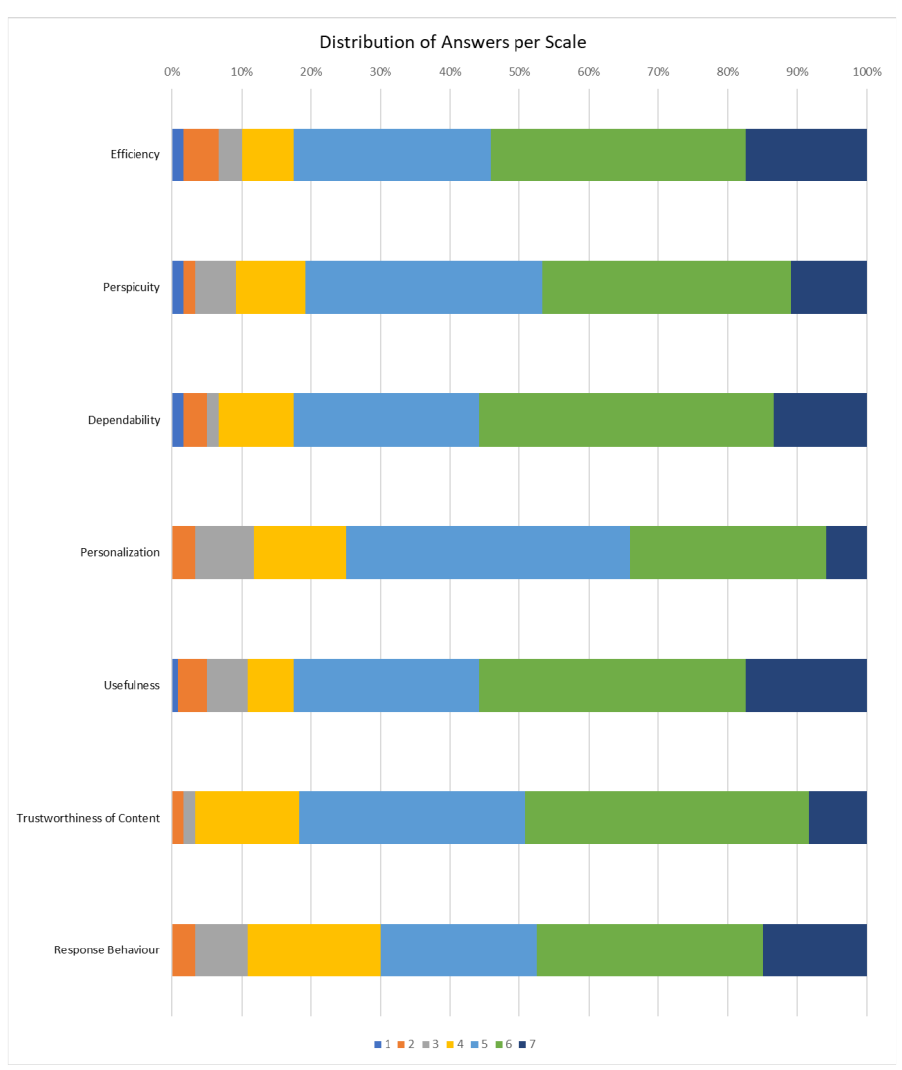
Figure 12. Standard Deviation of scales.